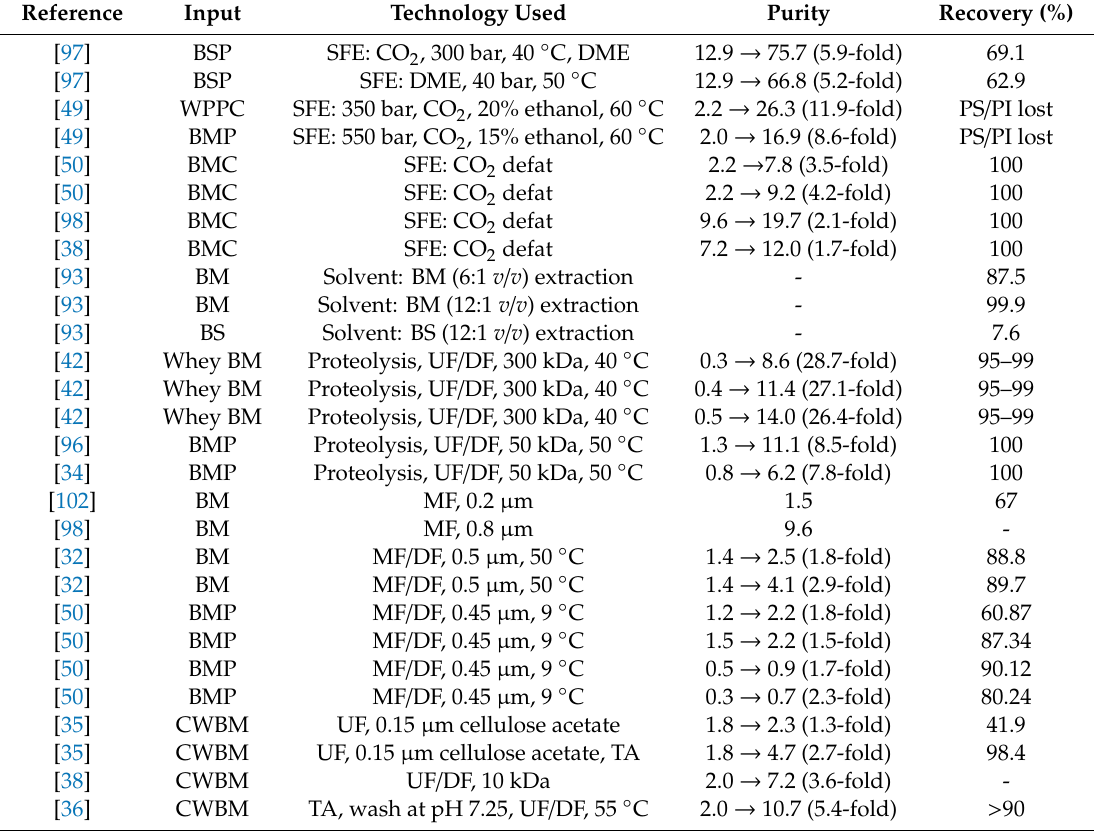
Table 3. Process to purify MPLs and achieved purity (g MPLs / 100 g dry